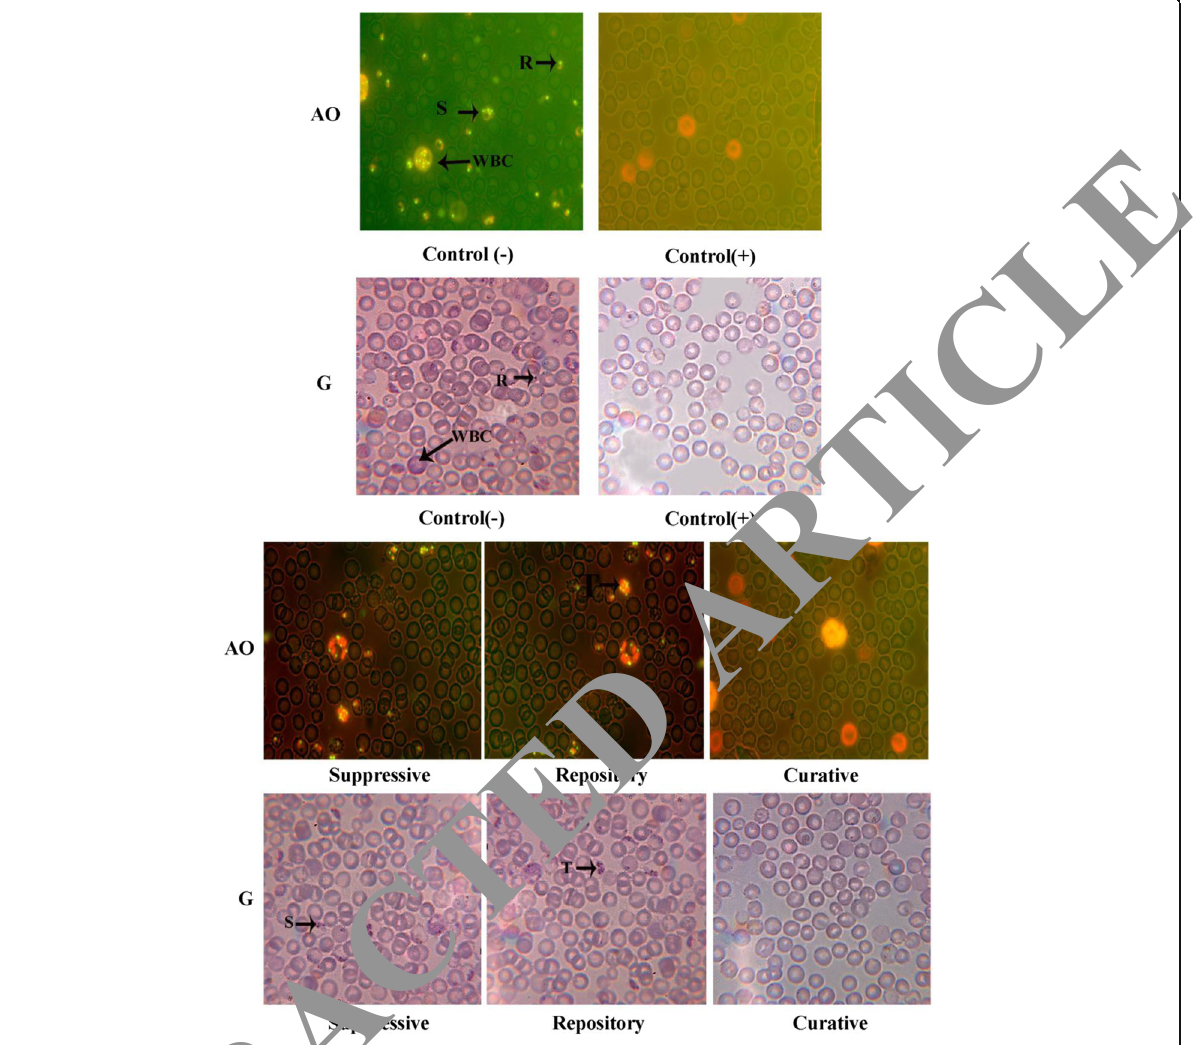
Fig. 6 Microscopic observations after treatment with methanolic bark extract of Pongamia pinnata against Plasmodium berghei strain at the highest concentration (1000 mg/kg b.wt./day) with Giemsa(G) and Acridine Orange (AO) at 1000× magnification (R- ring stage, T- trophozoite, S- schizont, WBC- white blood